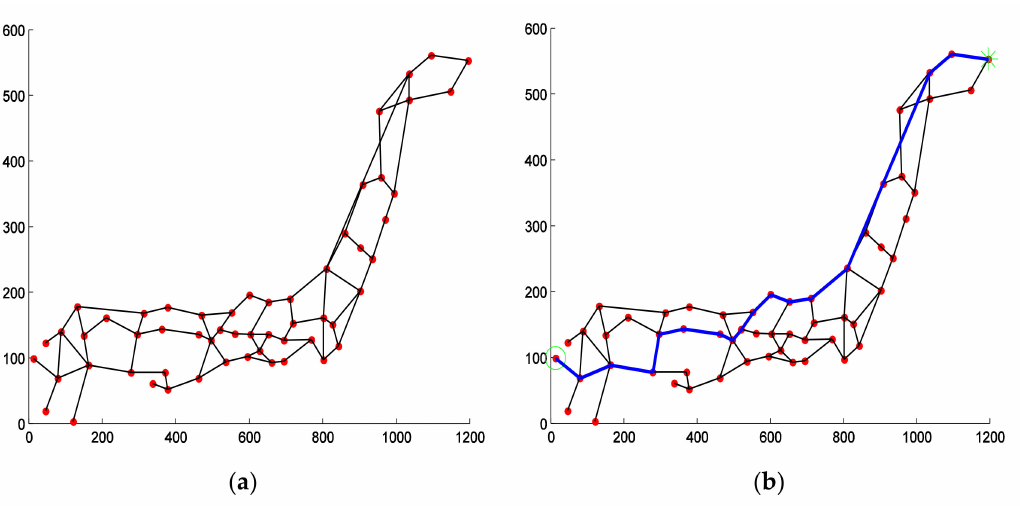
Figure 4. Experiment on real WMNs network. ( a ) the NTT network topology. ( b ) Anypath P ∗ s found by